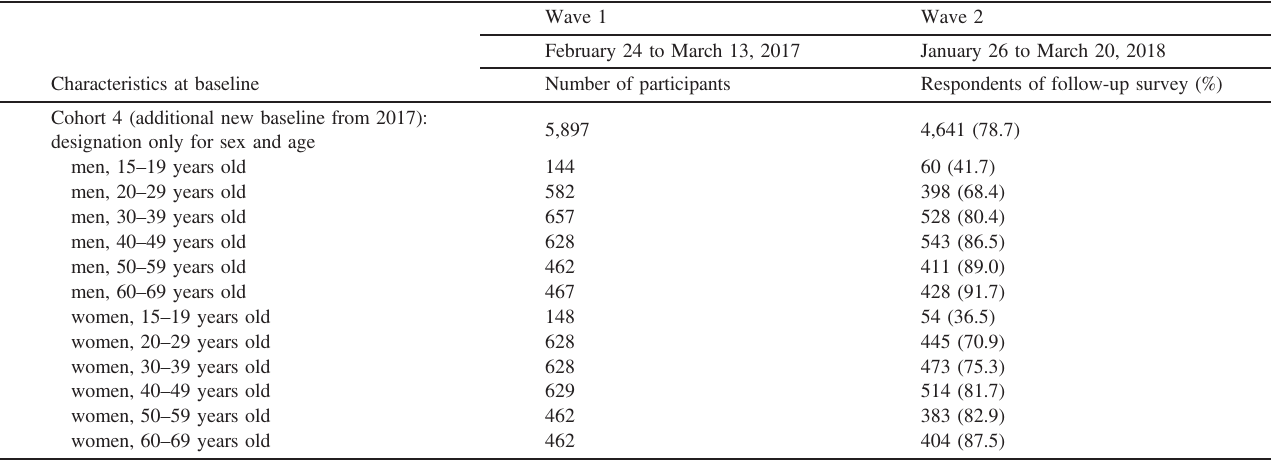
Table 3. Number of participants in the JASTIS study (Cohort 4)